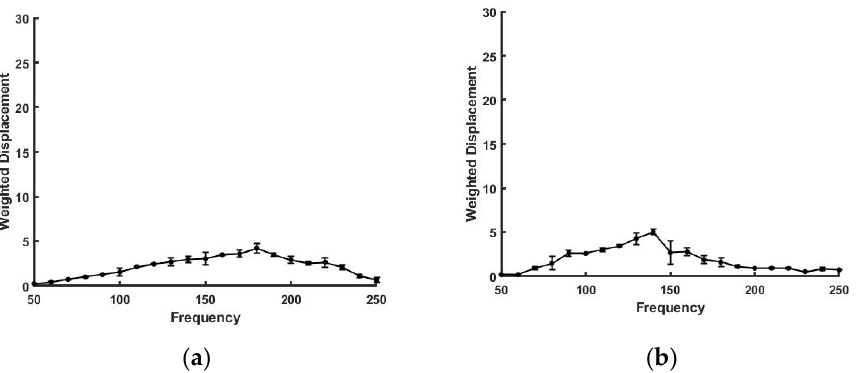
Figure 4. Weighted displacement in μ m vs. frequency in Hz for a Viton rubber gasket. Data are shown before ( a ) and after ( b ) high-temperature exposure in an automotive transmission. Note the increased breadth of the resonant frequency peak as a function of frequency reflecting the large molecular weight distribution of the crosslinked polymer chains compared to silicone rubber shown in Figure 3.